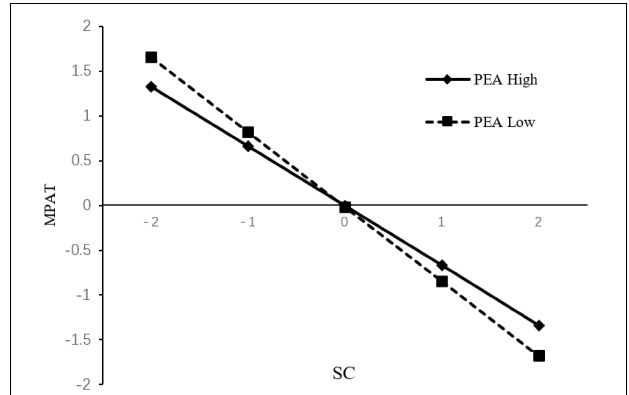
FIGURE 3 | PEA moderates the relationship between SC and